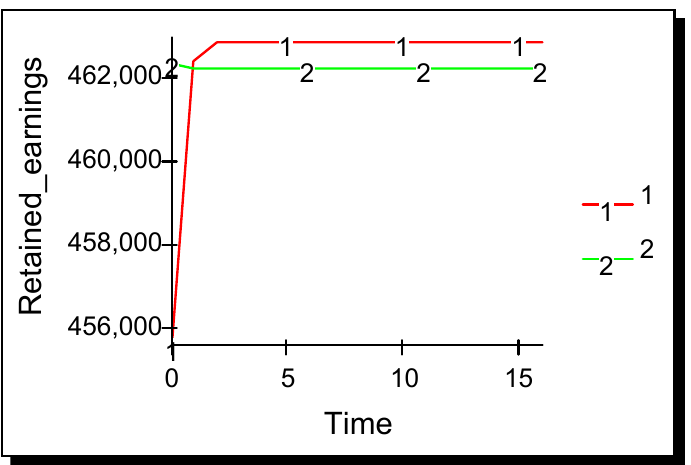
Figure 4. Unilateral advertising, below threshold. Advertising effectiveness: φ 1 = 0.000001; φ 2 = 0.